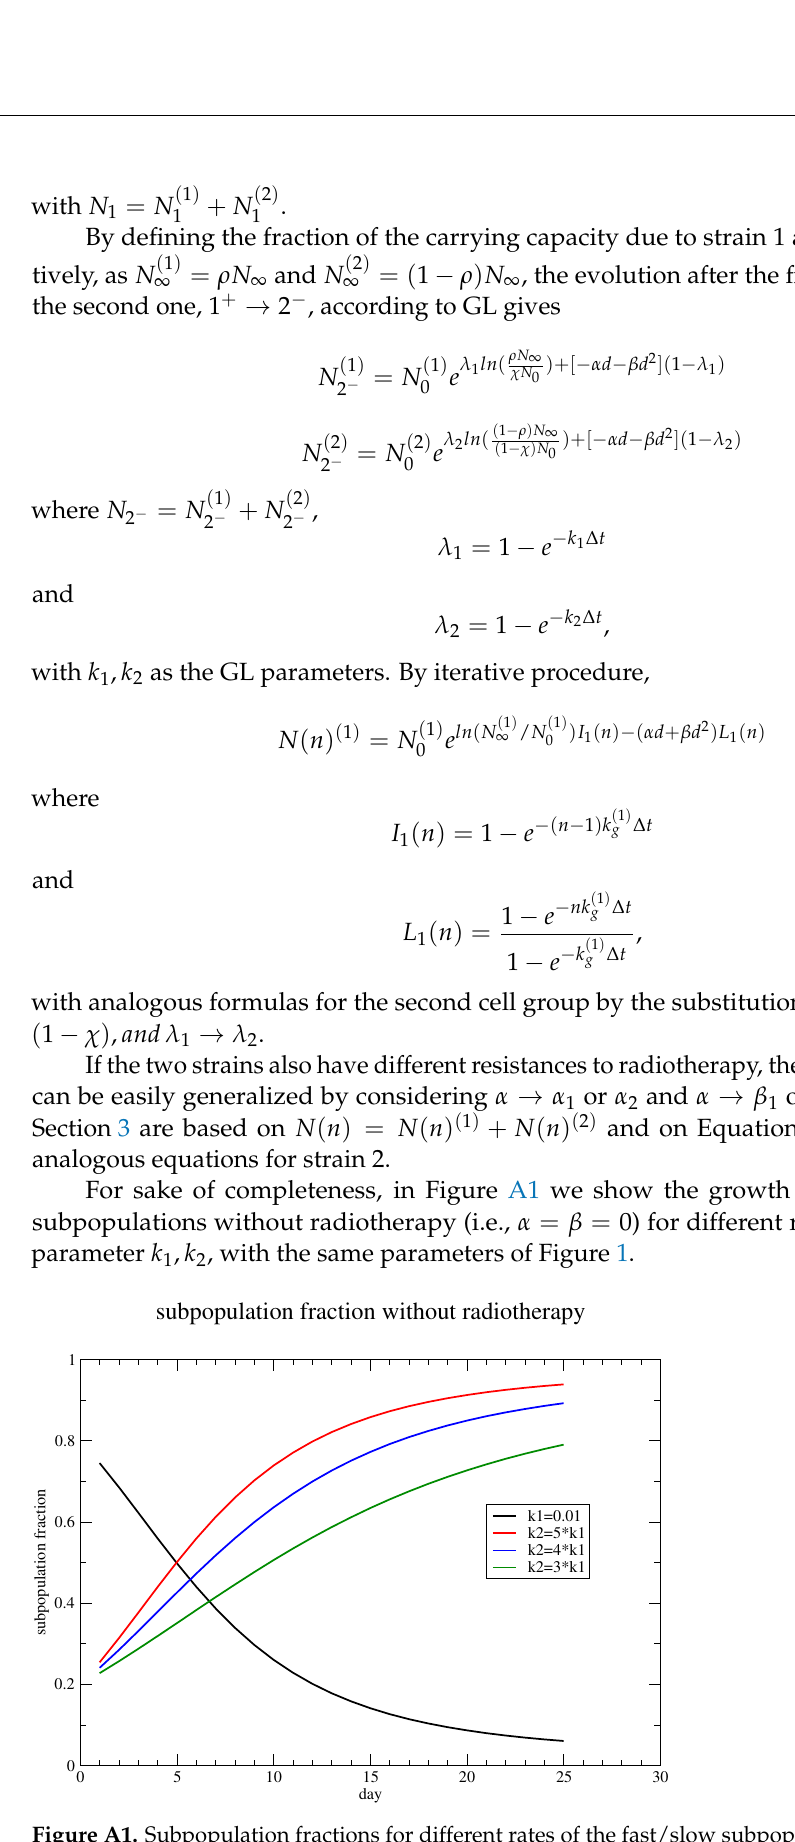
Figure A1. Subpopulation fractions for different rates of the fast/slow subpopulation, with the same parameters as in Figure